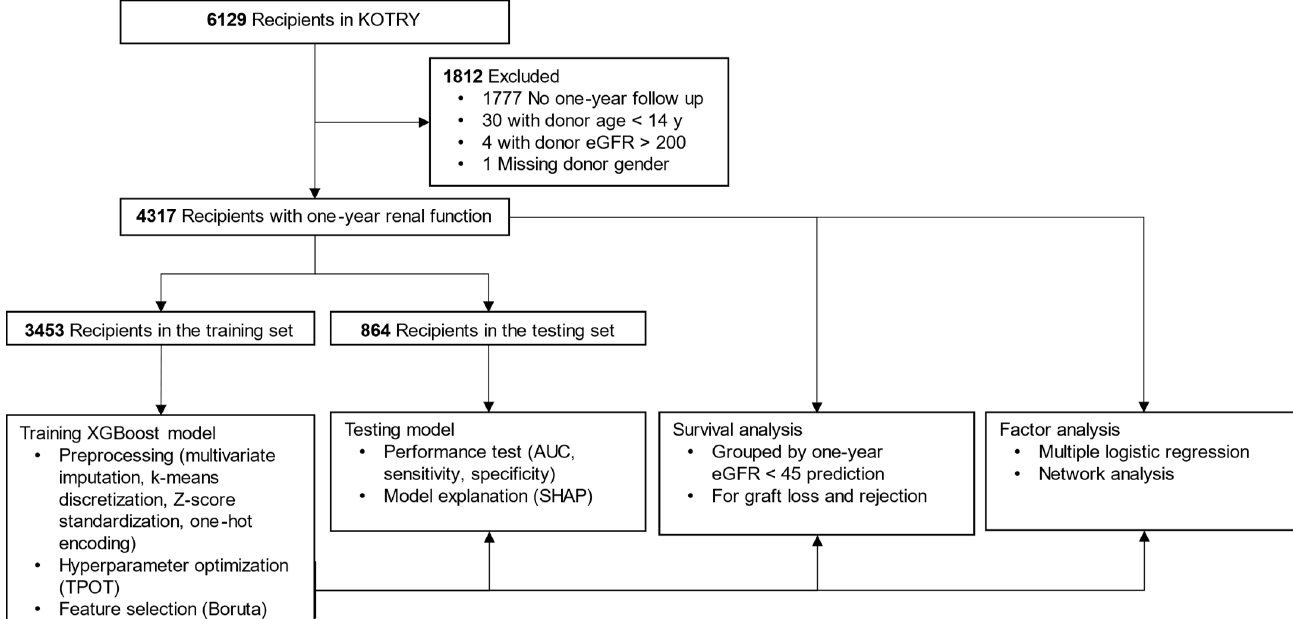
Figure 1. Flow diagram showing data processing and study methods. Abbreviations: KOTRY, Korean Organ Transplant Registry; eGFR, estimated glomerular filtration rate (mL/min/1.73 m 2 ); XGBoost, extreme gradient boosting; TPOT, tree-based pipeline optimization tool; AUC, area under the curve; SHAP, shapley additive explanation. Table 1. Study variables.